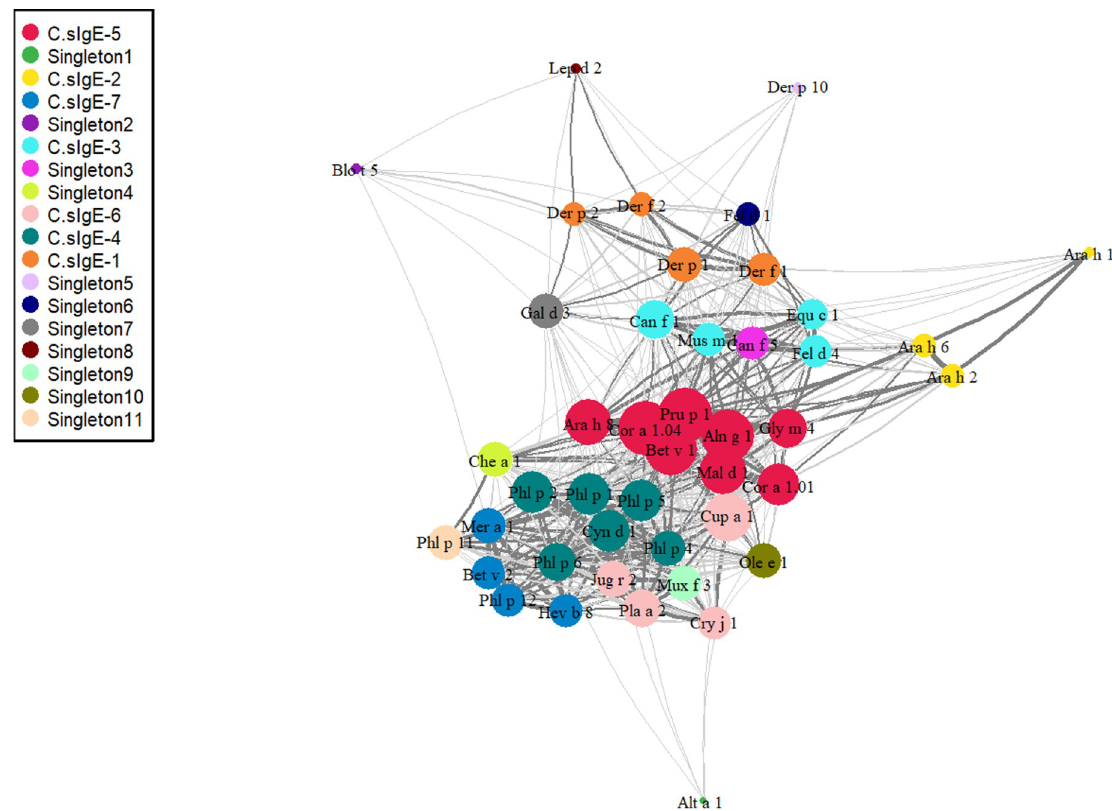
Fig 2. Component-specific IgE network and hierarchical cluster reveal connectivity structure in sIgE. The network consists of a set of nodes, joined in pairs by lines or edges. Colours represent cluster memberships and node diameter is proportional to the scaled connectivity of each sIgE, while edge colour and width represent the strength of connection between pairs of sIgE components. IgE, immunoglobulin E; sIgE, specific immunoglobulin